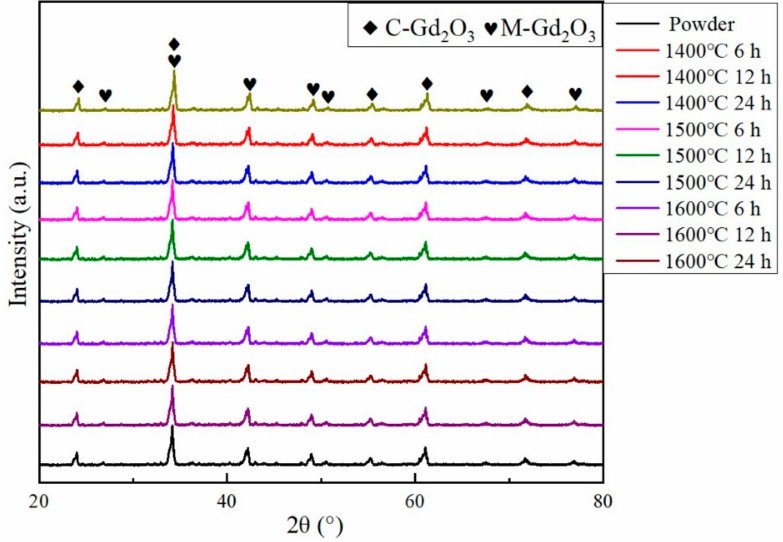
Figure 3. X-ray diffraction patterns of the Gd 2 O 3 powder and the sintered bulks.